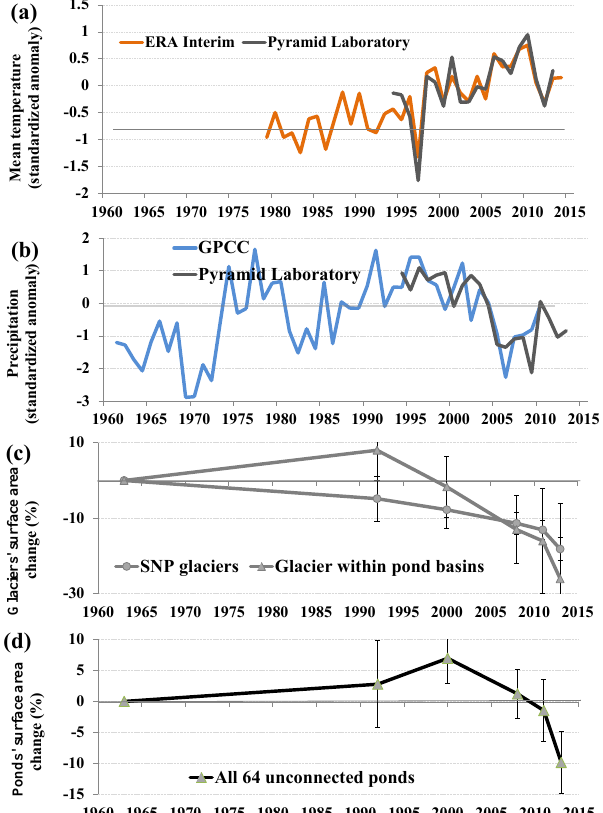
Figure 4. Trend analysis of climate and glaciers’ and ponds’ surface area for the last 50 years in the SNP: (a) ERA-Interim mean annual temperature compared with Pyramid’s land-based data; (b) GPCC annual precipitation and Pyramid’s land-based data; (c) glacier sur- face area variations for the overall SNP (Thakuri et al., 2014) and for glaciers located in basins of 64 considered ponds. (d) Surface area variations of all 64 considered ponds. Y axis units: (a) and (b) trends are expressed in terms of standardized anomalies divided by the standard deviation (dimensionless); (c) and (d) relative vari- ations with respect to 1963. Errors bars represent the uncertainty of